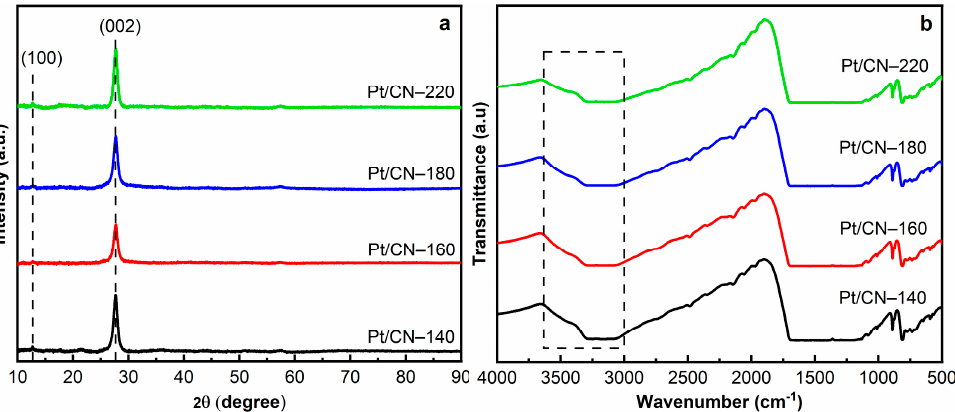
Figure 4. The XRD patterns ( a ) and FTIR spectra ( b ) of the Pt/CN photocatalysts.